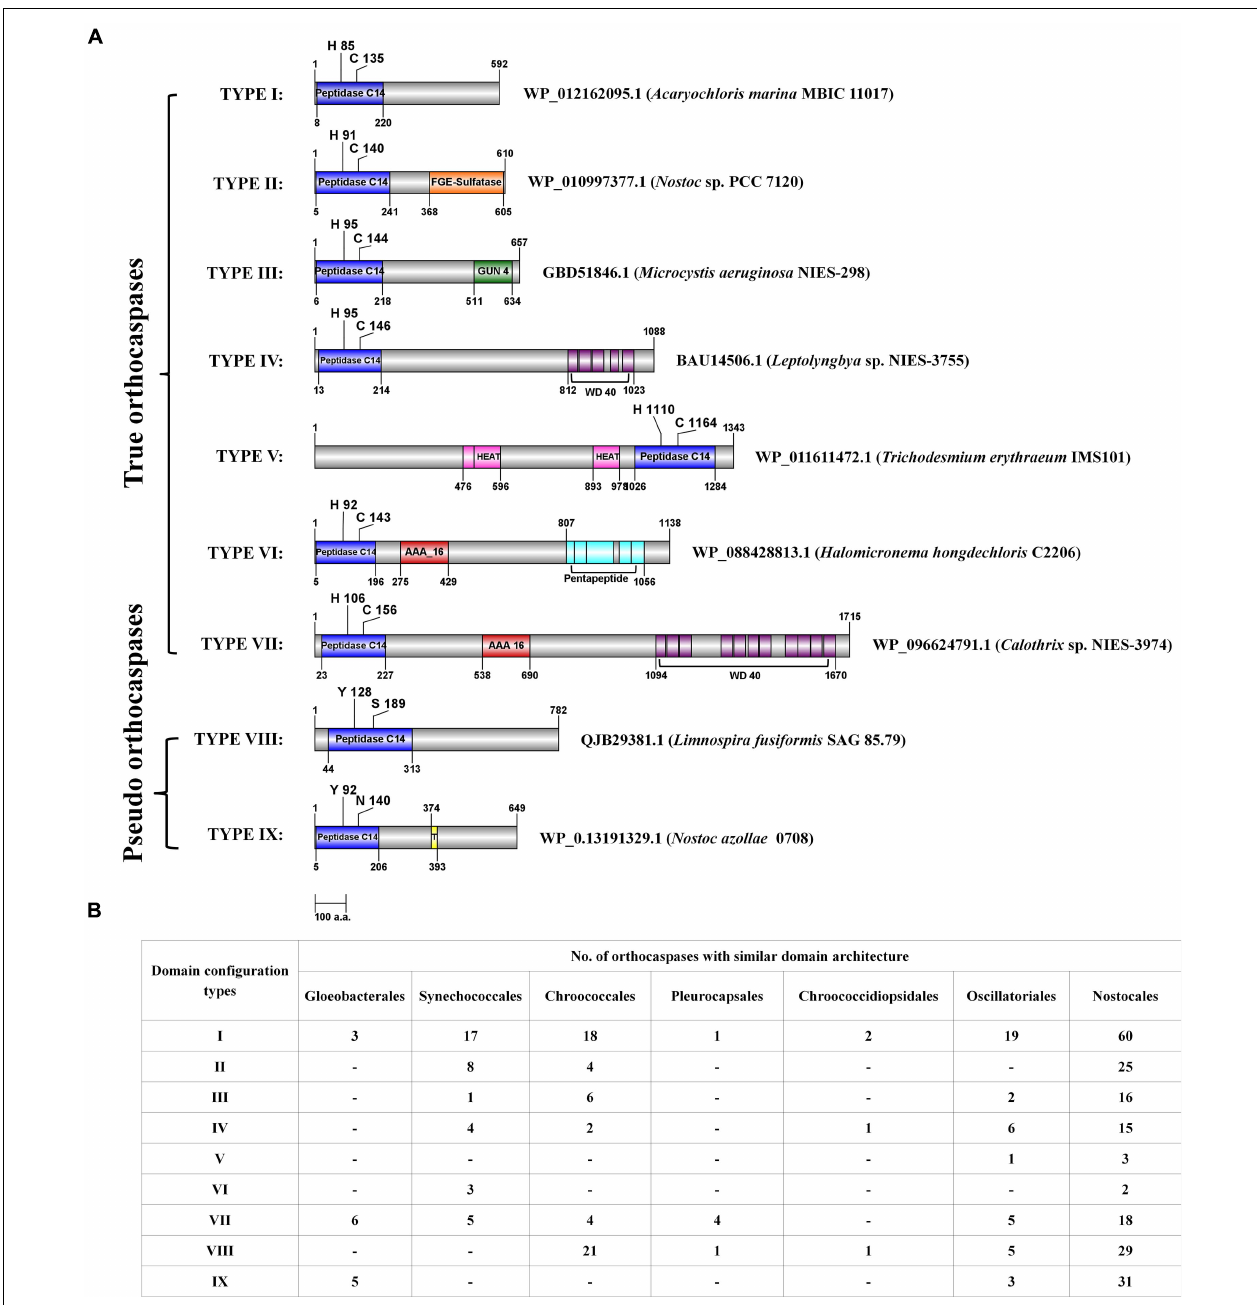
FIGURE 2 | The domain configurations of few putative cyanobacterial orthocaspases with commonly observed accessory domains, and their distribution among taxonomical orders. (A) The domain configurations were categorized into nine different types, and a representative sequence was used to depict the position of domains for each type. Domain architectures obtained CD search using the Pfam database ( e -value = 0.01). NCBI accession numbers and strain names are provided for the representative sequence. The figure is drawn to scale with numbers representing protein or domain length (amino acid numbers). Catalytic residues are indicated with a single-letter amino acid code with a position specifier. (B) The distribution of various domain configuration types among cyanobacterial orders is shown. Note that the configuration, i.e., the N- and C-terminal orders of domains, is the same in all the sequences sharing a particular type of domain architecture. However, the position of domain and catalytic residues shown in panel (A) may vary among the